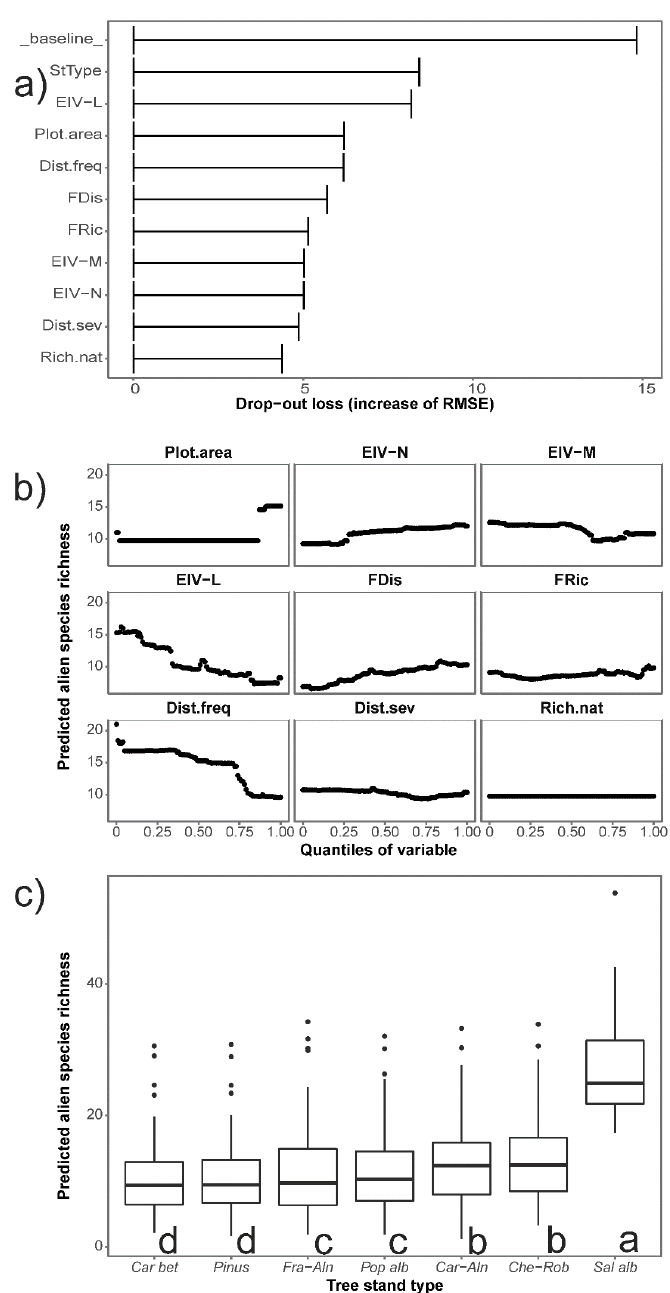
Figure 3. Alien species cover explained by a random forest model. ( a ) Importance of variables, expressed by drop-out loss in the model RMSE when a particular variable was perturbed (baseline refers to permuted model responses, dashed line indicates value for the full model). ( b ) Partial dependence plots (ceteris paribus plots) showing changes of predictions when a particular predictor was changed while all remaining predictors were constant. ( c ) Partial group predictions for predicted alien species cover assuming constant levels of other predictors. Boxes represent interquartile range and median and whiskers represent minimum–maximum range in forest vegetation types: Car-Aln — Carici elongatae-Alnetum , Car bet — Carpinion betuli , Che-Rob — Chelidonio-Robinietum , Fra-Aln — Fraxino-Alnetum , Pinus —monocultures of Pinus sylvestris , Pop alb — Populetum albae , and Sal alb — Salicetum albae . For further details, see Tables S2 and S3. Vegetation types marked by the same letter did not differ statistically significantly in predicted alien species cover, according to the Tukey posteriori test at p = 0.05. According to data transformation, values were scaled into relative percentiles.